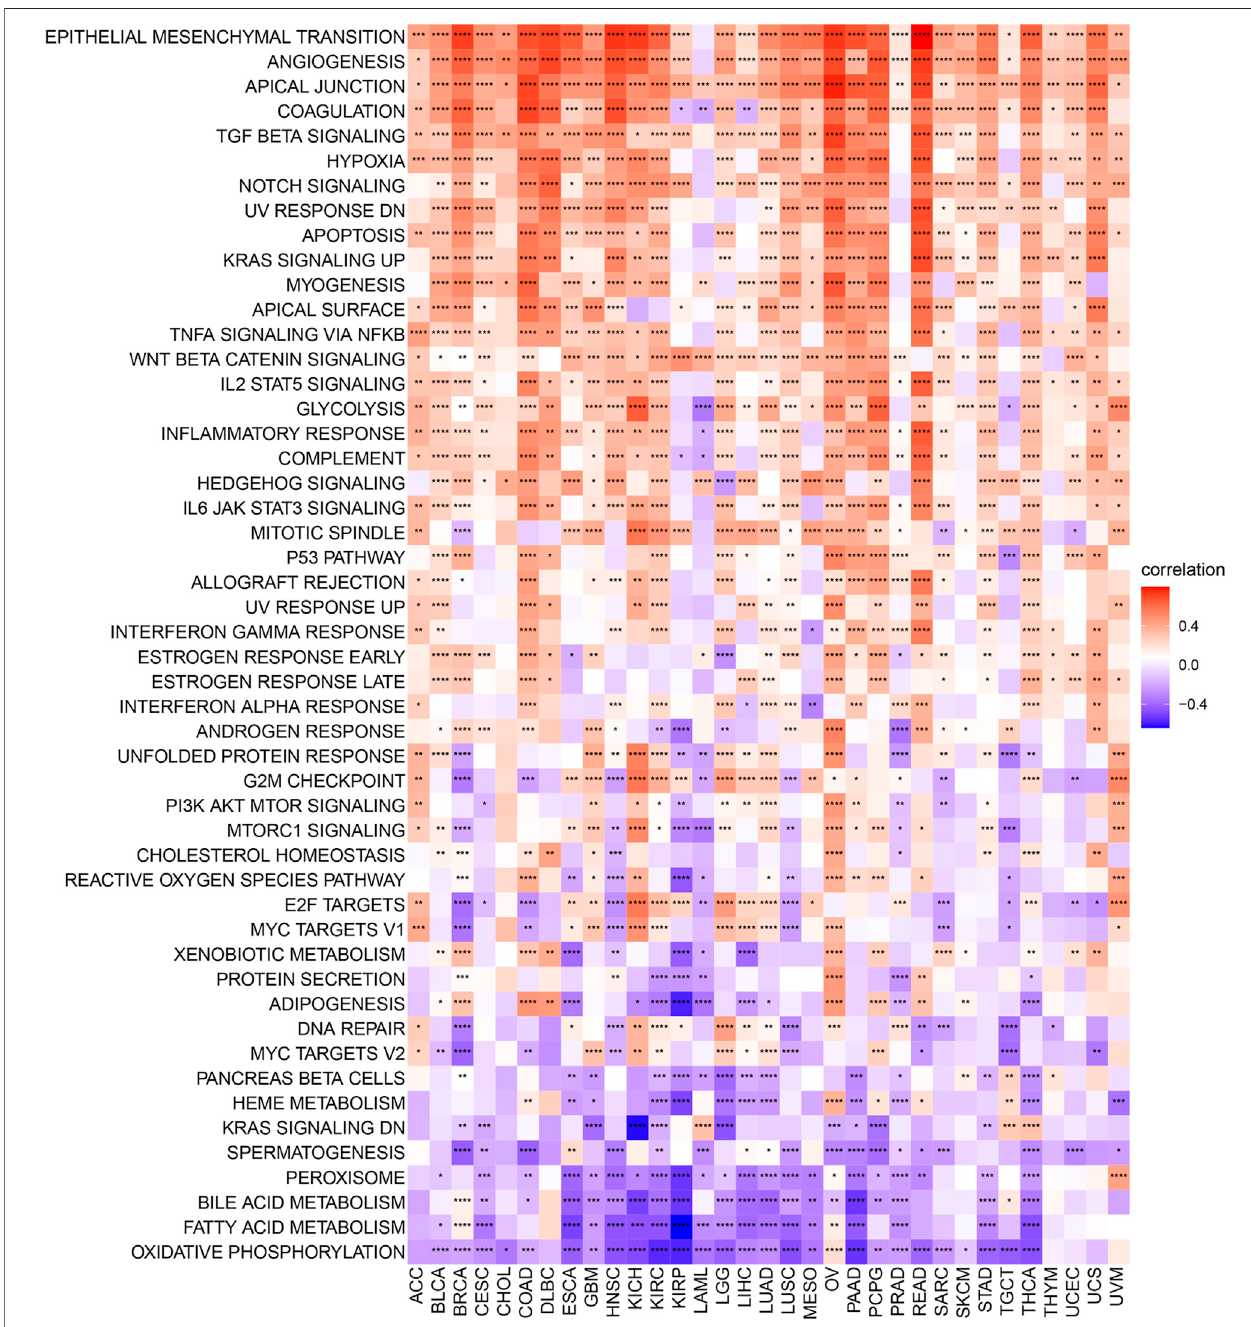
Frontiers in Pharmacology |